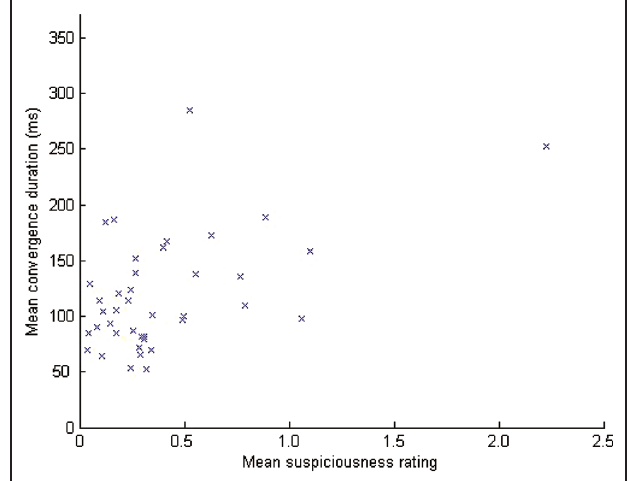
FIGURE 3 | The relationship between convergence period duration and ratings of perceived suspiciousness for untrained observers.